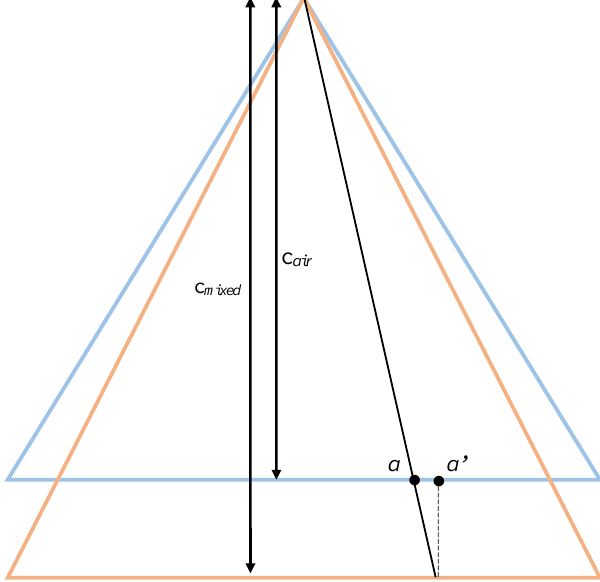
Figure 8. Repositioning of a photo point based on the calculated focal length (c mixed ).